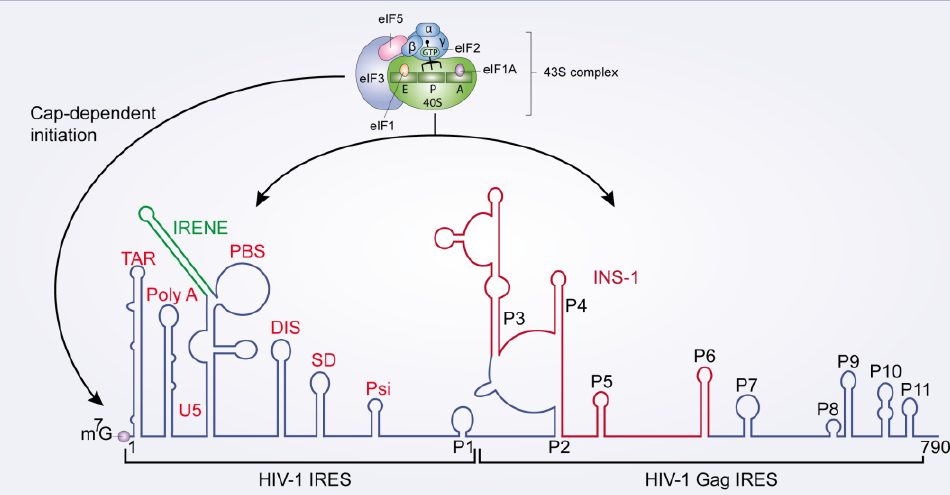
Figure 4. HIV-1 IRESs. HIV-1 IRES and HIV-1 Gag IRESs are represented. The 43S pre-initiation complex can mediate both cap-dependent and IRES-mediated translation